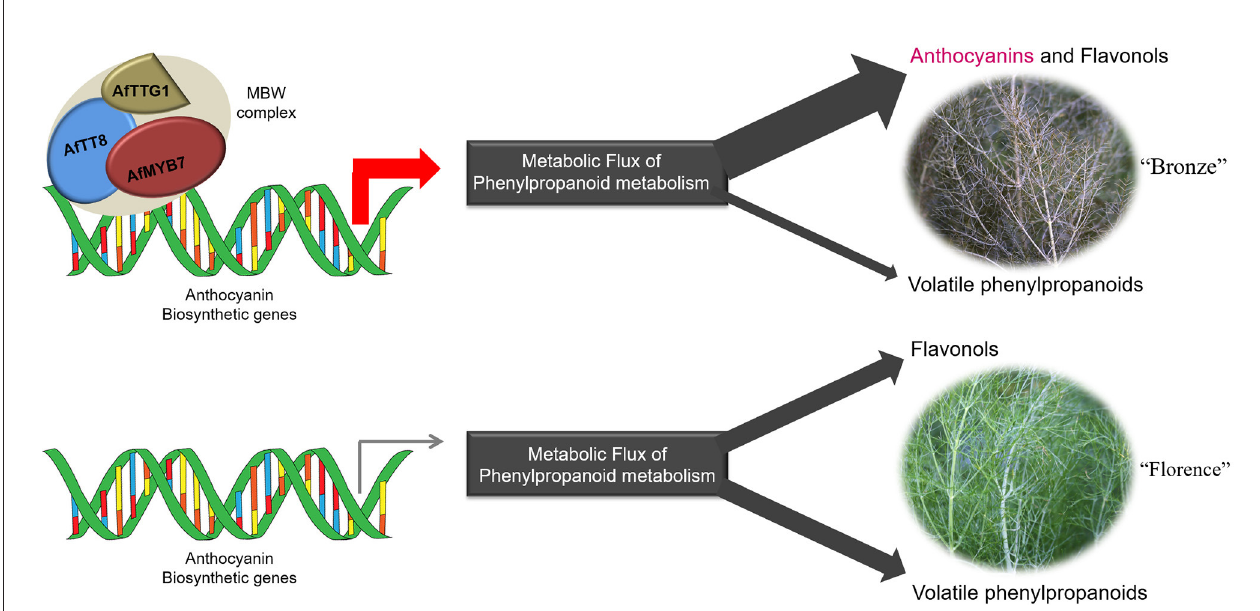
FIGURE 8 | The ternary MBW complex consisting of AfTT8, AfMYB7 and AfTTG1 regulates anthocyanin coloration and aroma formation in fennel through activating the anthocyanin biosynthetic genes at mRNA level and redirecting the metabolic flux of phenylpropanoid metabolism.